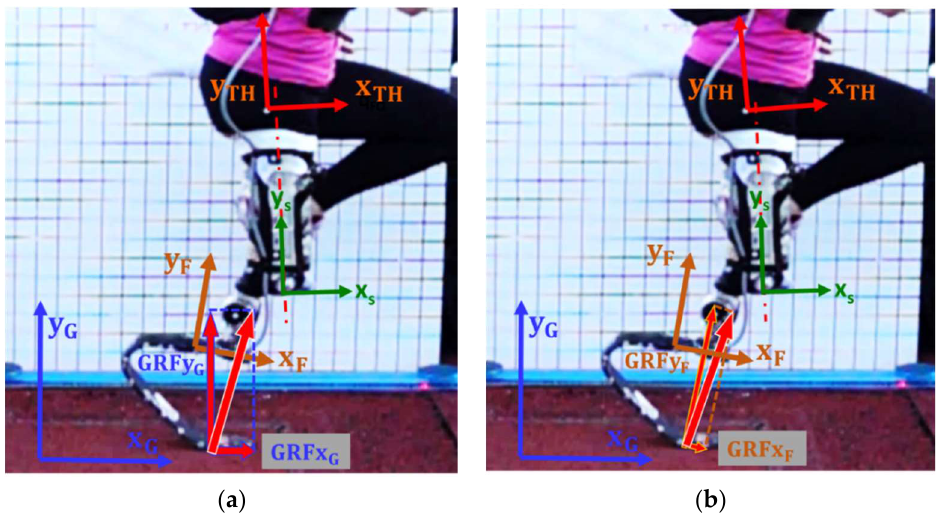
Figure 3. Example of GRF components in the push phase of a KD RSP resolved in different Reference Systems: ( a ) GRF components the Global reference system and ( b ) GRF components in the Foot reference system. See Appendix A for reference systems definitions.